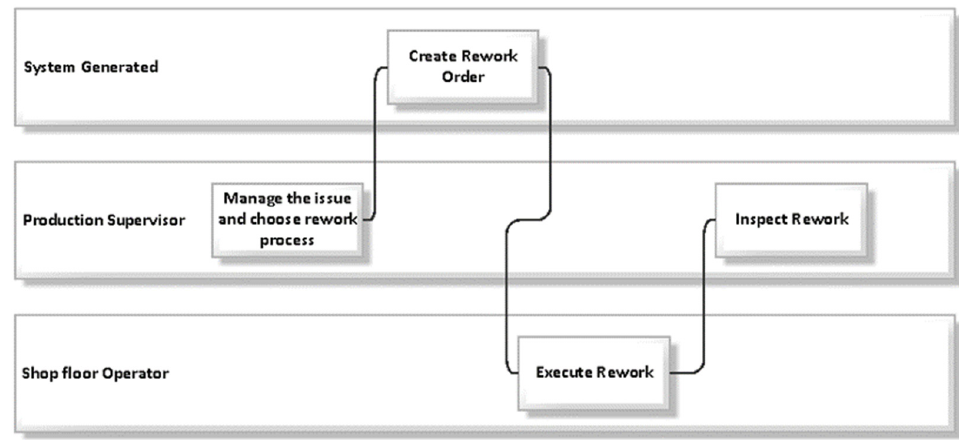
Figure 4. Rework triggered by production supervisor scheme [27].